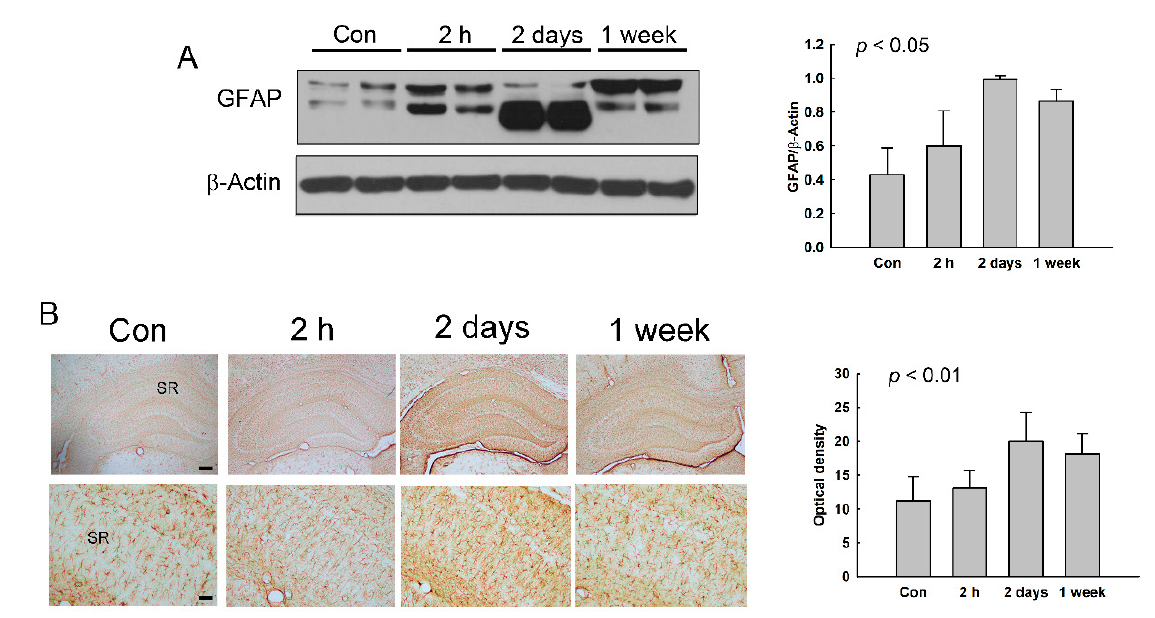
Figure 7. The expression of glial fibrillary acidic protein (GFAP) in the hippocampus of NMDA-treated rats. ( A ) The expression of GFAP in the hippocampus was assessed using Western blotting. The histograms represent the protein expression levels divided by the expression level of β -actin as the mean ± SD. β -Actin was used as an internal control. ( B ) The GFAP immunoreactivity (IR) was examined in the hippocampus. The optical density of GFAP IR is shown as the mean ± SD. Scale bars indicate 200 (low magnification) or 50 μ m (high magnification). SR: stratum radiatum.